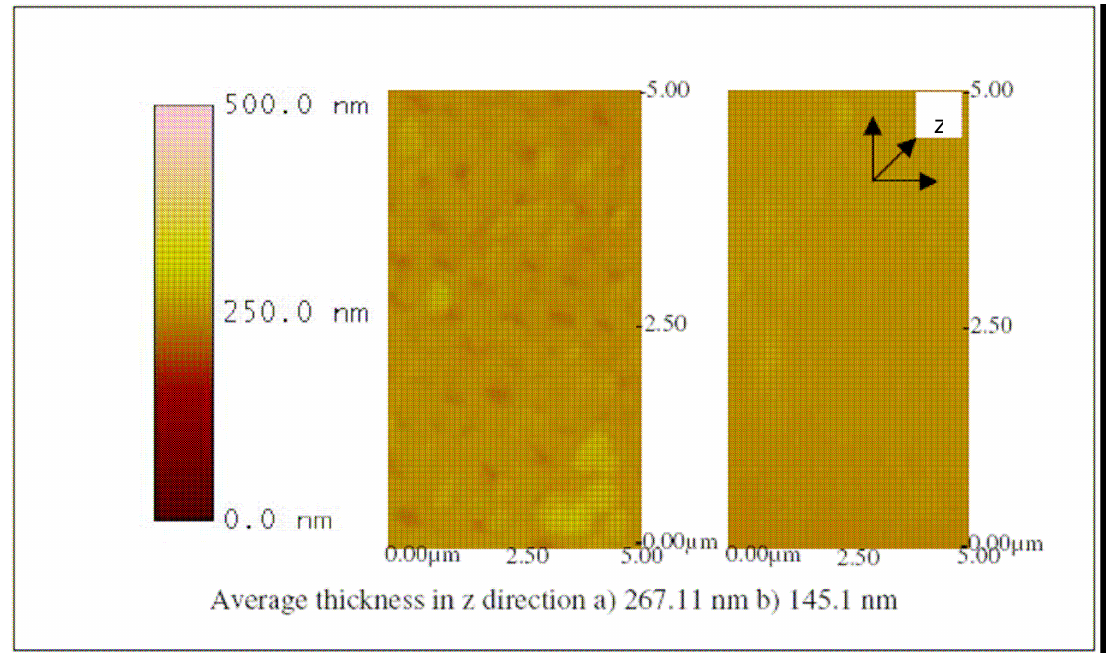
Figure 14. Atomic force microscopy images of a) ITO-Pani biosensor (20KDa) tested with a) 10 6 CCID/ml and b) 10 4 CCID/ml of bovine viral diarrhea virus